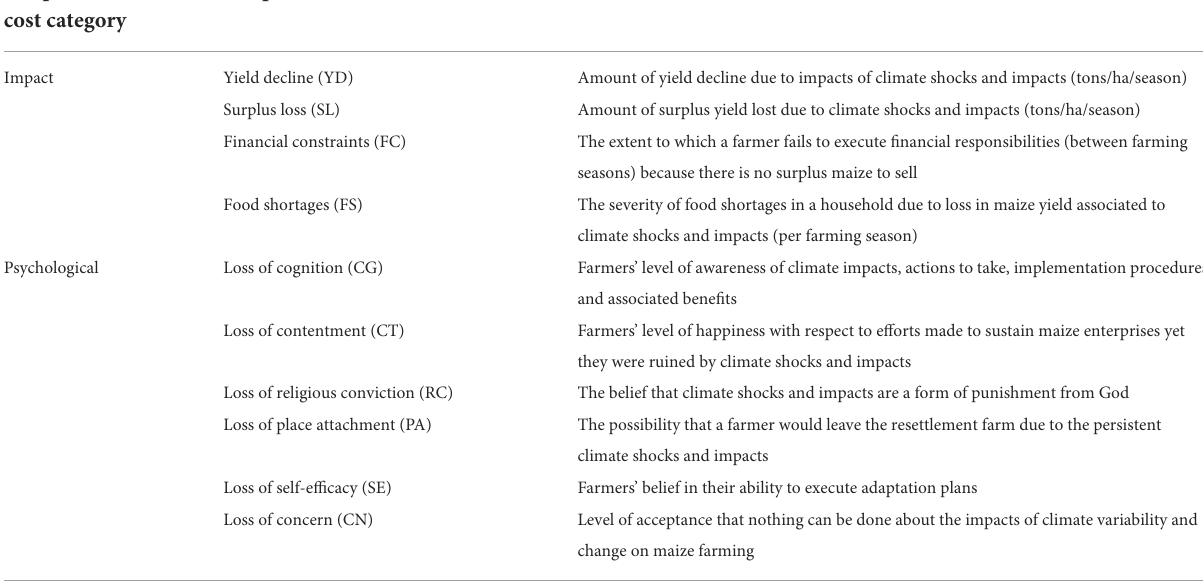
TABLE 2 Pre-adaptation cost categories, variables and definitions.